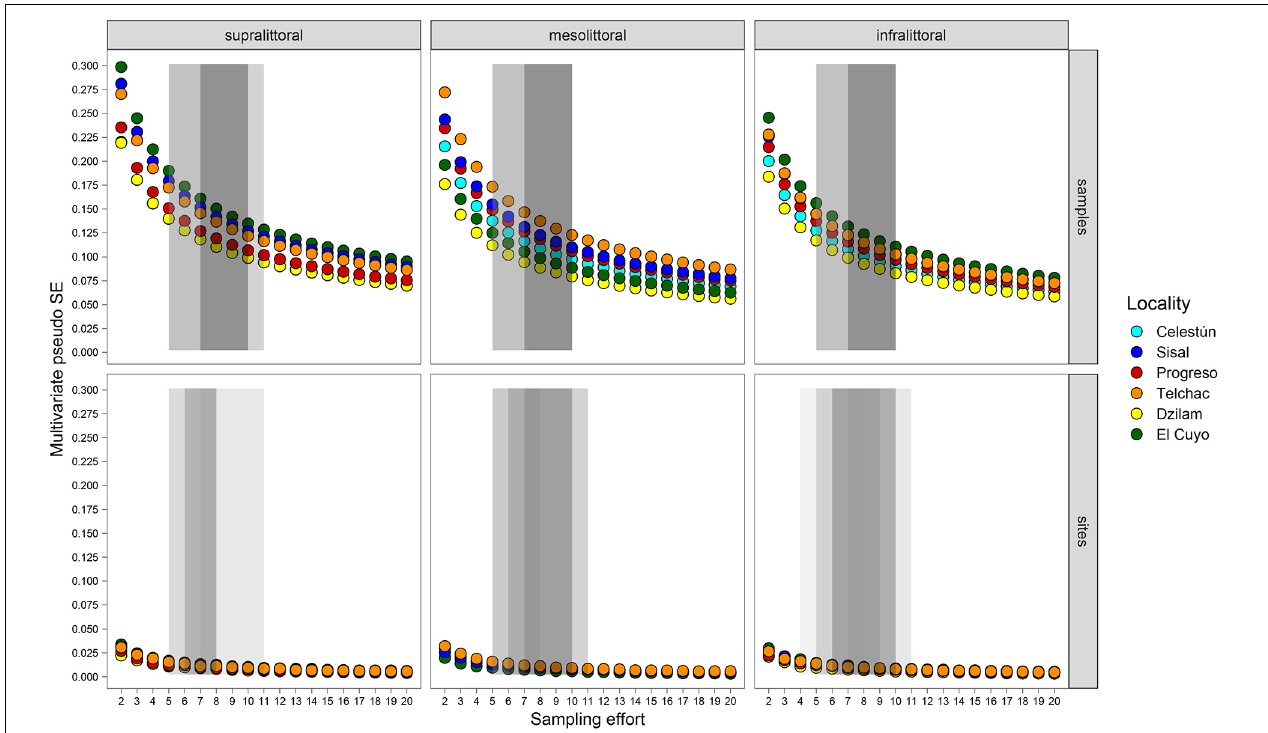
FIGURE 7 | Behaviors of MultSE for each stratum in each of the localities. 10 simulations were performed, in each one 20 virtual sites were generated for each stratum, with 100 potential sampling units. In each simulation, n = 2 to n = 20 and sites m = 2 to m = 20 were resampled, each combination of n and m was repeated 10 times. For each, the MultSE was estimated. The optimal sampling range is presented independently for each locality-stratum as a light gray box. The overlapping of the boxes (dark gray) indicates the coincidence of the optimal sampling ranges between all the locations.